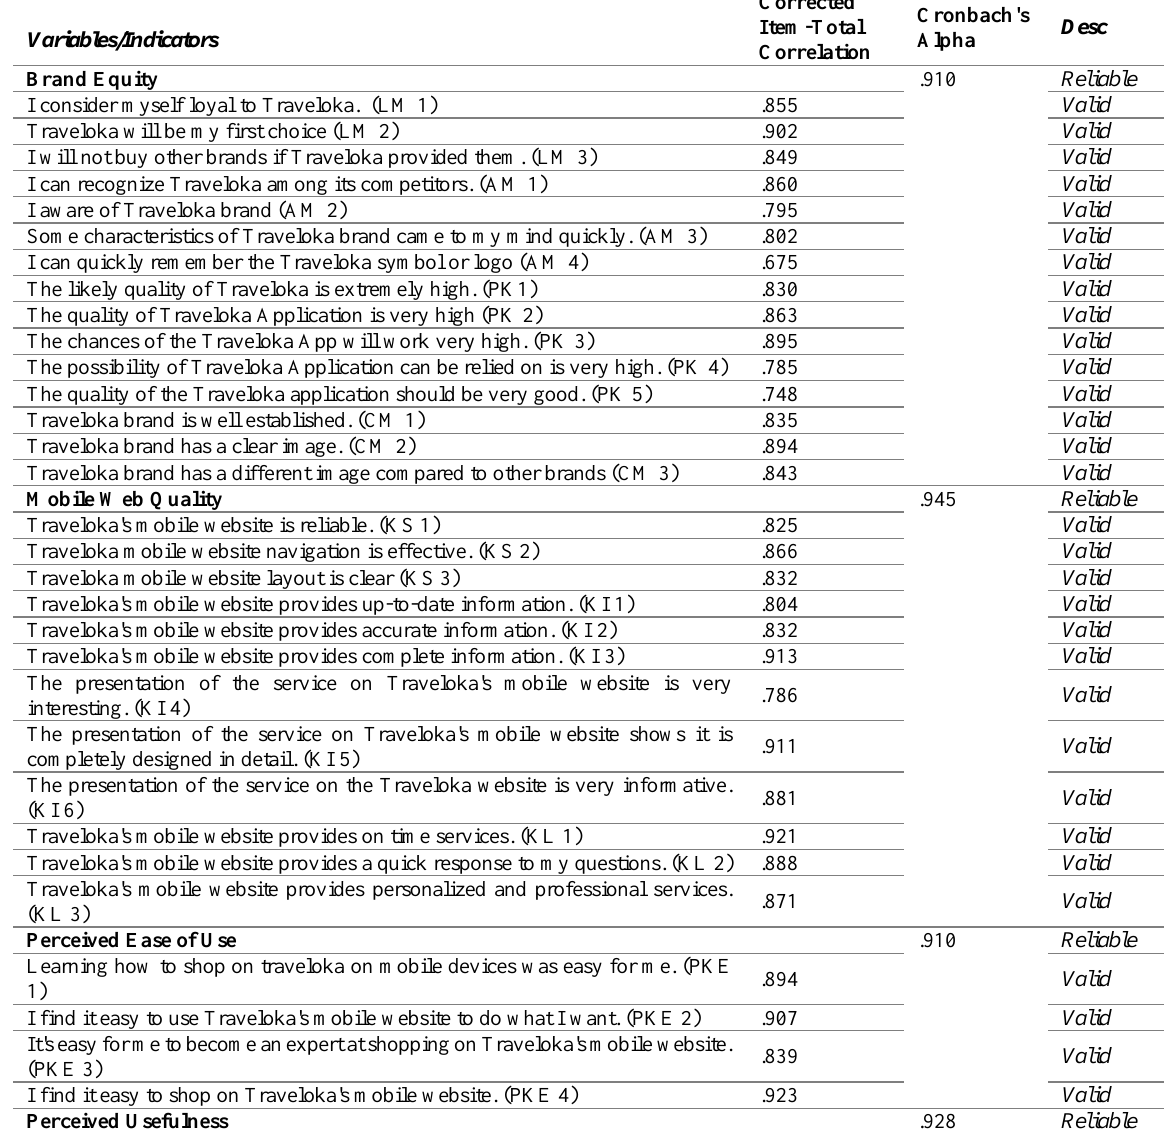
Table 1: Results of Test Validity and Reliability of Research Instrument